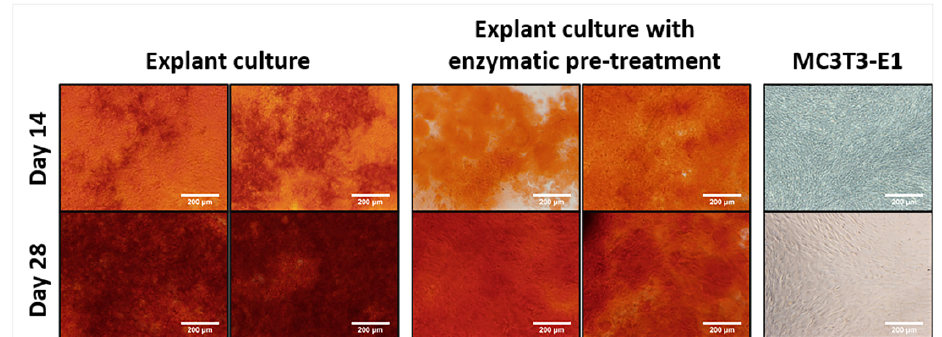
Figure 3. ECM mineralization stained by ARS promoted by rOBs isolated either by explant culture with enzymatic pre-treatment or by explant culture on days 14 and 28. Images from two individuals for each isolation method are shown. MC3T3-E1 served as a control. Magnification 100×, scale bar 200 μ m.